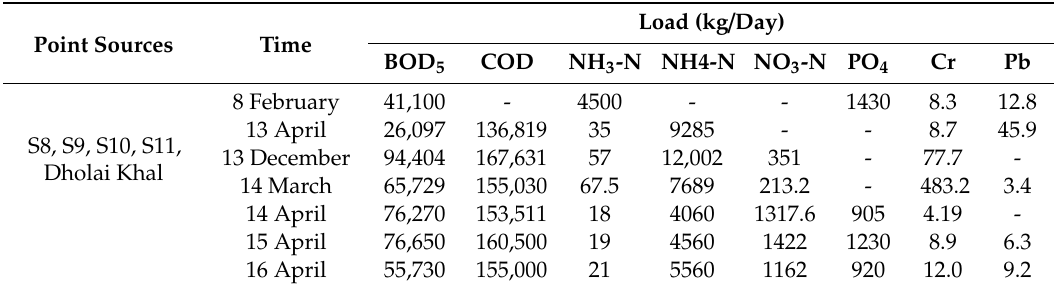
Table A2. Pollution load into the peripheral Buriganga through di ff erent point sources, e.g., wastewater drains.